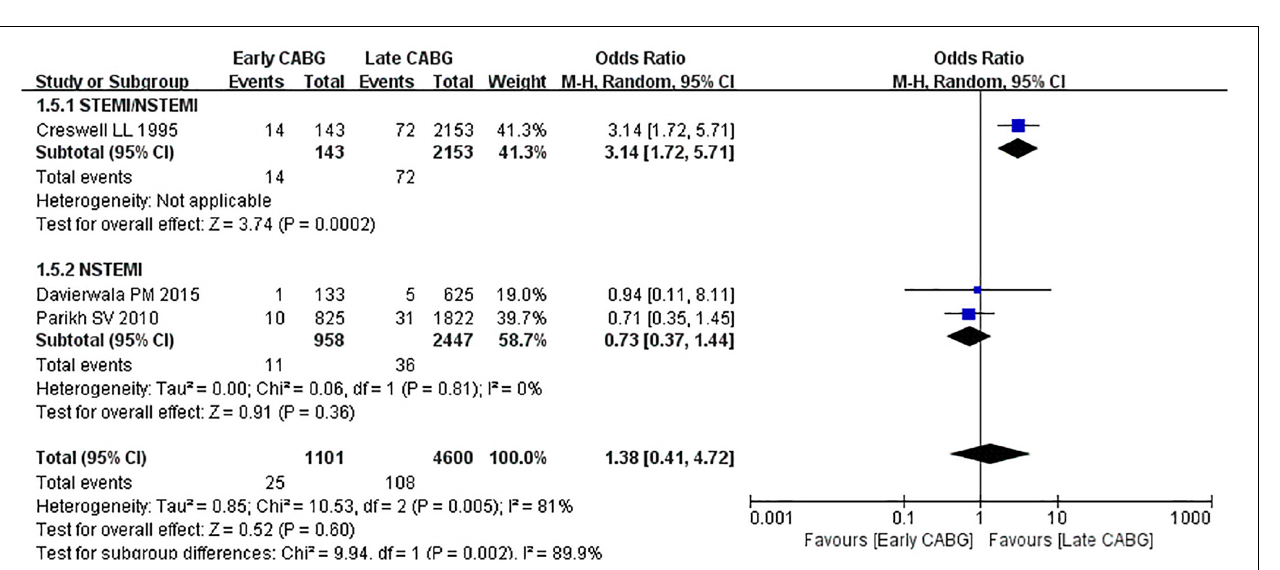
FIGURE 5 | Perioperative myocardial infarction in early CABG groups vs. late CABG groups.